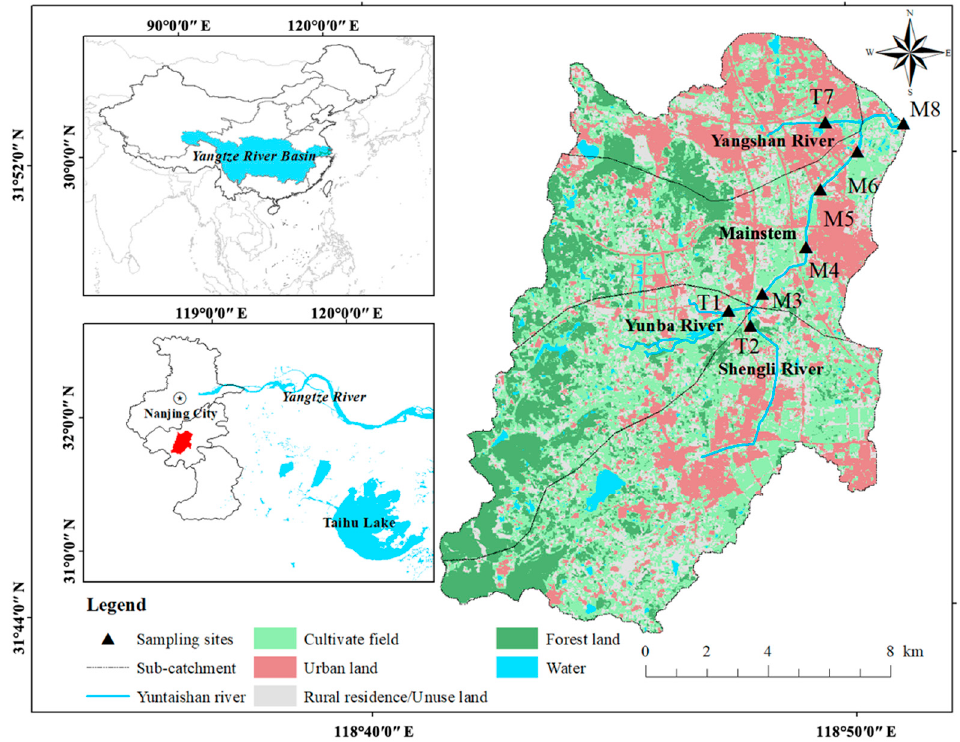
Figure 1. Location of sampling sites and land use types in Yuntaishan River basin, Nanjing, East China. Table 1. Different land-use types in of Yuntaishan River sub-catchments.